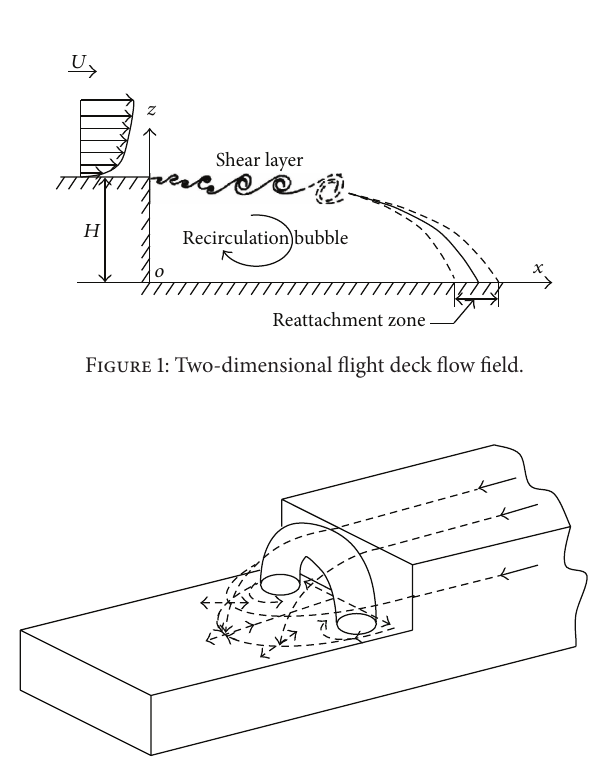
Figure 2: Three-dimensional flight deck flow